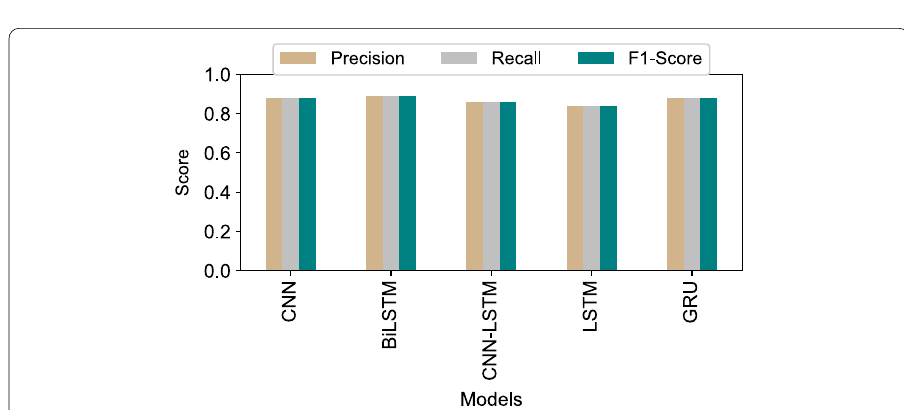
Fig. 4 Weighted average score of deep learning models with pre-trained word embedding and data augmentation